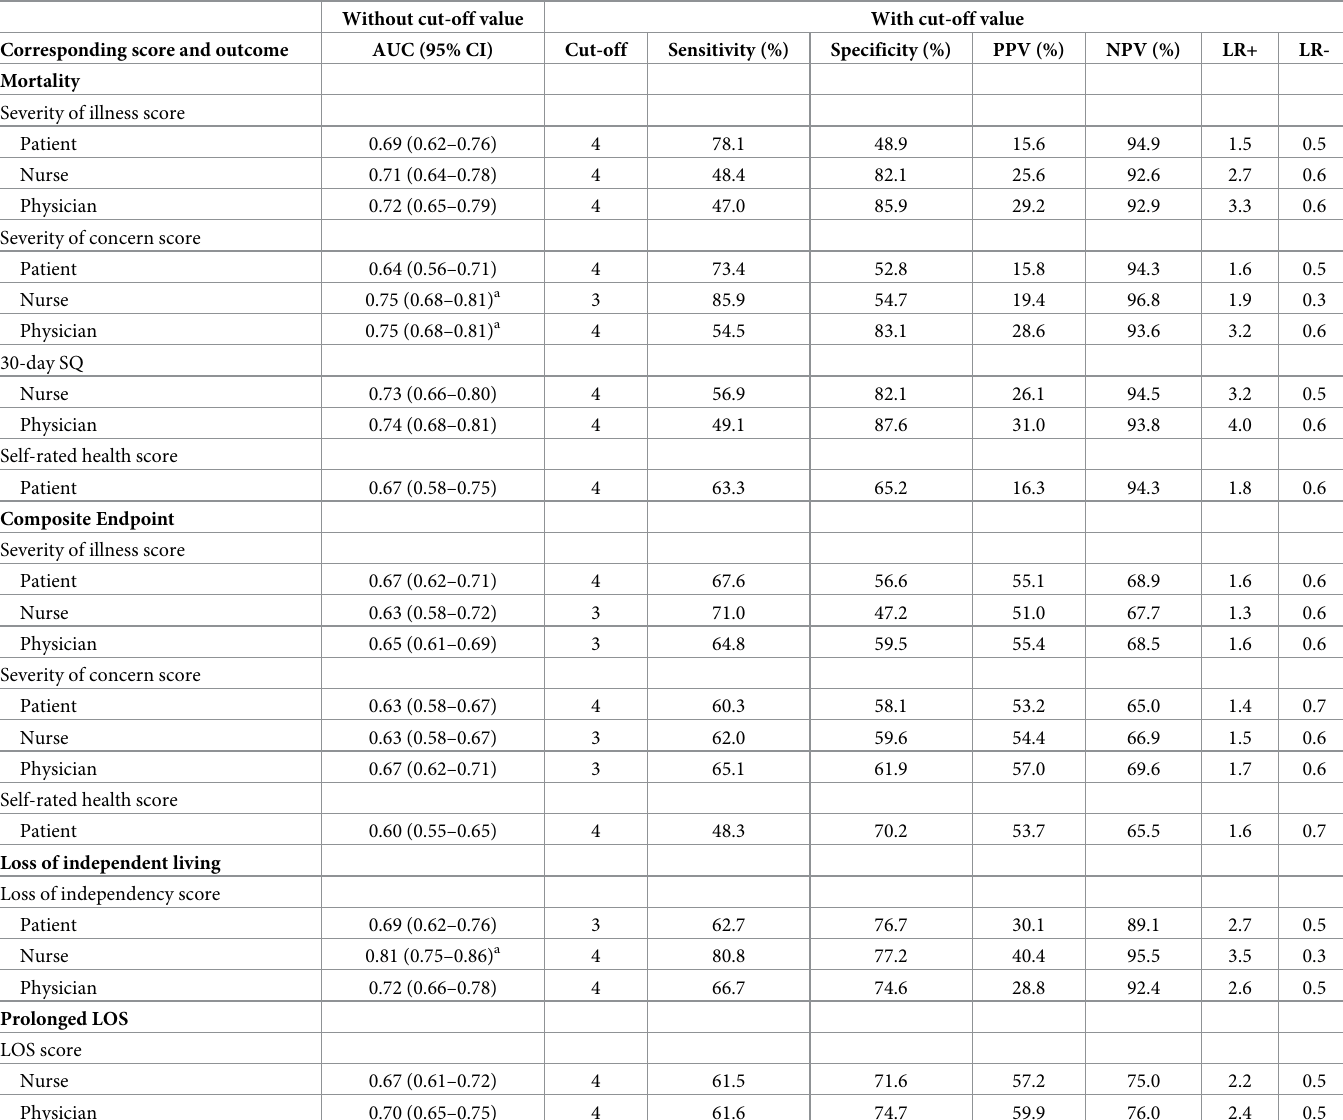
Table 3. Predictive ability of the